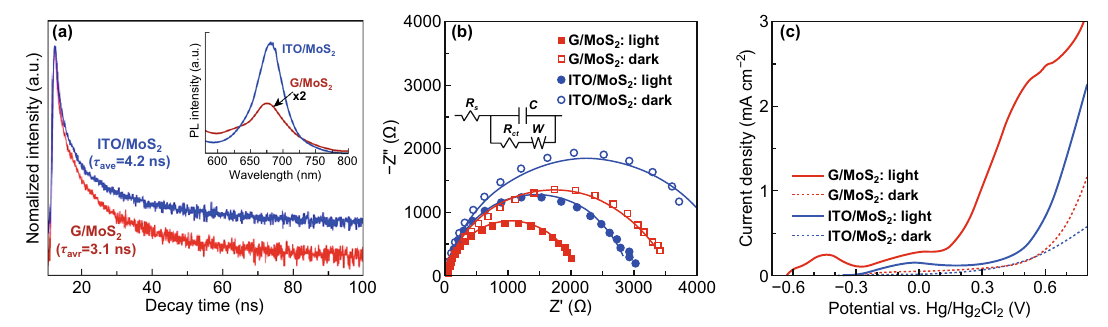
Fig. 4 a TRPL results of ITO/MoS 2 and G/MoS 2 . The inset shows the corresponding PL spectra. b Nyquist plots of ITO/MoS 2 and G/MoS 2 in the dark and under illumination. The inset shows the equivalent Randles circuit. c Photo‑ and dark current densities versus the potential curves of PEC cells with working electrodes of ITO/MoS 2 and G/MoS